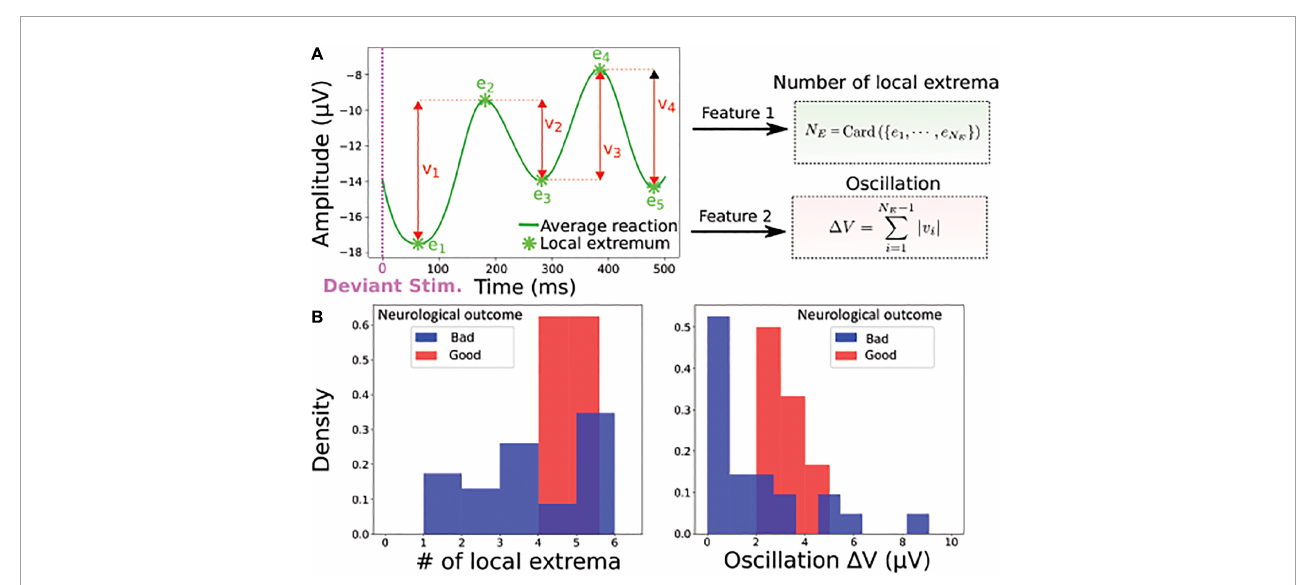
FIGURE3 Statistical features associated to deviant responses. (A) Left: the average filtered evoked response (blue) to deviant stimuli computed over the entire time window contains N E local extrema e i (minimum or maximum), which is the first feature. The second feature is the oscillation | (cid:49) V | = P i | V ( e i ) − V ( e i + 1 ) | , which is the sum of the absolute value of the difference between two consecutive extrema of the average evoked response. (B) Example of feature distributions of dataset from all electrodes: local extrema (Left) and oscillation (Right) over the entire period; red (good neurological outcome) and blue (bad neurological